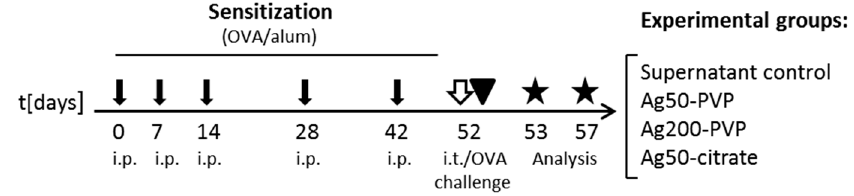
Figure 7. Experimental protocol. Sensitized (S) mice were intraperitoneally injected with 1 µg OVA in phosphate-buffered saline (PBS)/alum (black arrows). Non-sensitized (NS) mice were injected with PBS/alum. On day 52, mice were intratracheally instilled with Ag-NPs or with SUP (white arrow) and subsequently challenged with OVA aerosol (arrowhead). Mice were sacrificed on day 53 or on day 57 (stars).